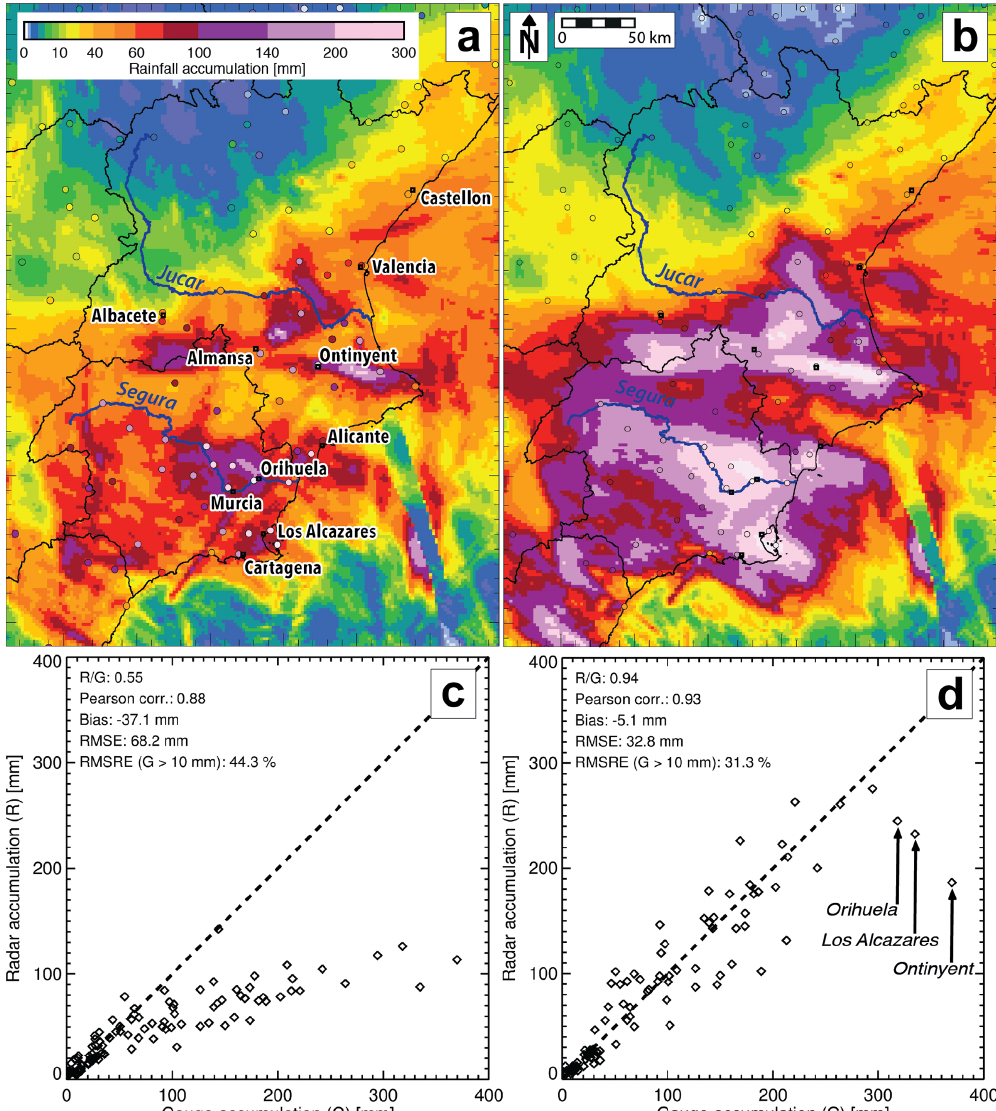
Figure 3. Total rainfall accumulation (11–14 September 2019) for the real-time-adjusted OPERA radar (a, c) and for the result of the radar– raingauge blending technique used throughout this paper (b) . (d) Performance of the radar–raingauge blending technique evaluated by means of (“leave-one-out”) cross validation. In panels (a) and (b) , the raingauge accumulation and their locations are represented by the circles, and the black lines are the limits of the catchment administrations of the Jucar (north) and the Segura